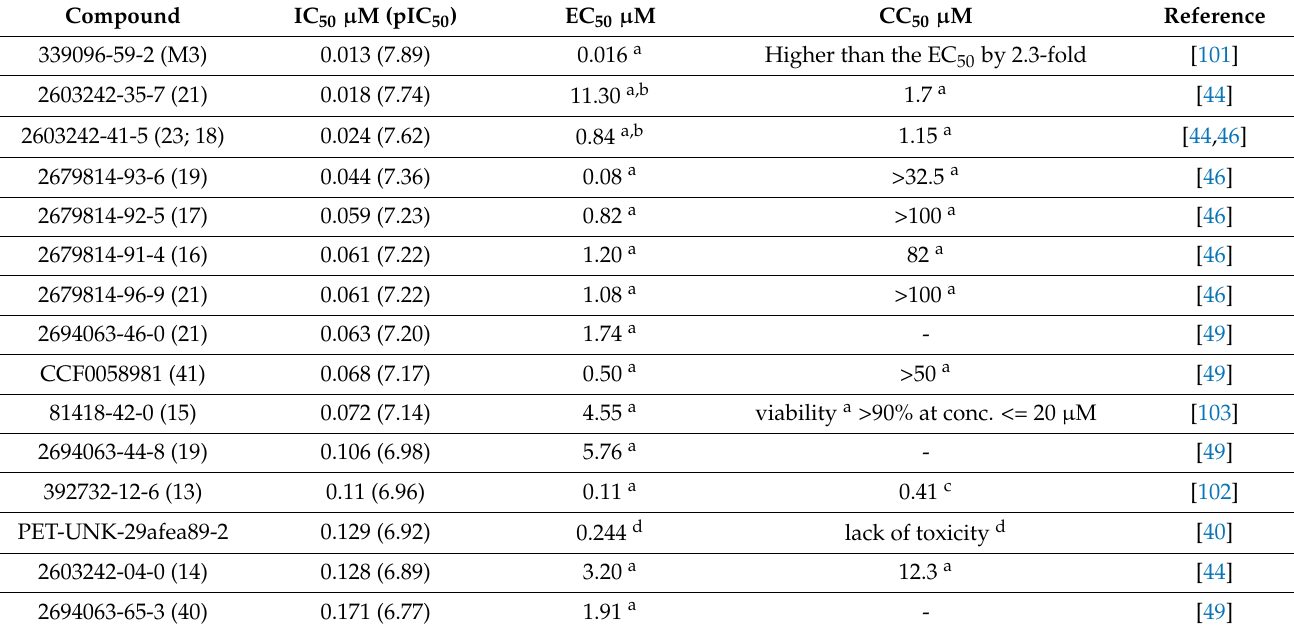
Table 3. Data from the 15 most potent non-covalent inhibitors of the SARS-CoV-2 M-pro.